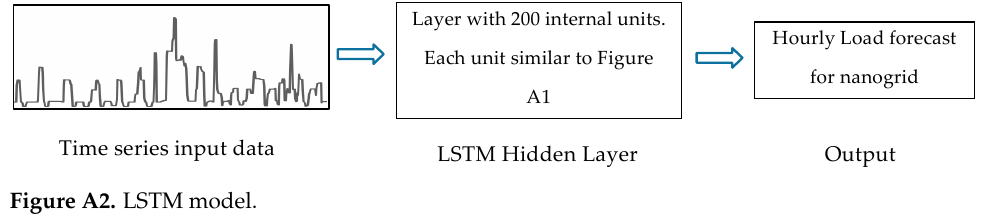
Figure A2. LSTM model.